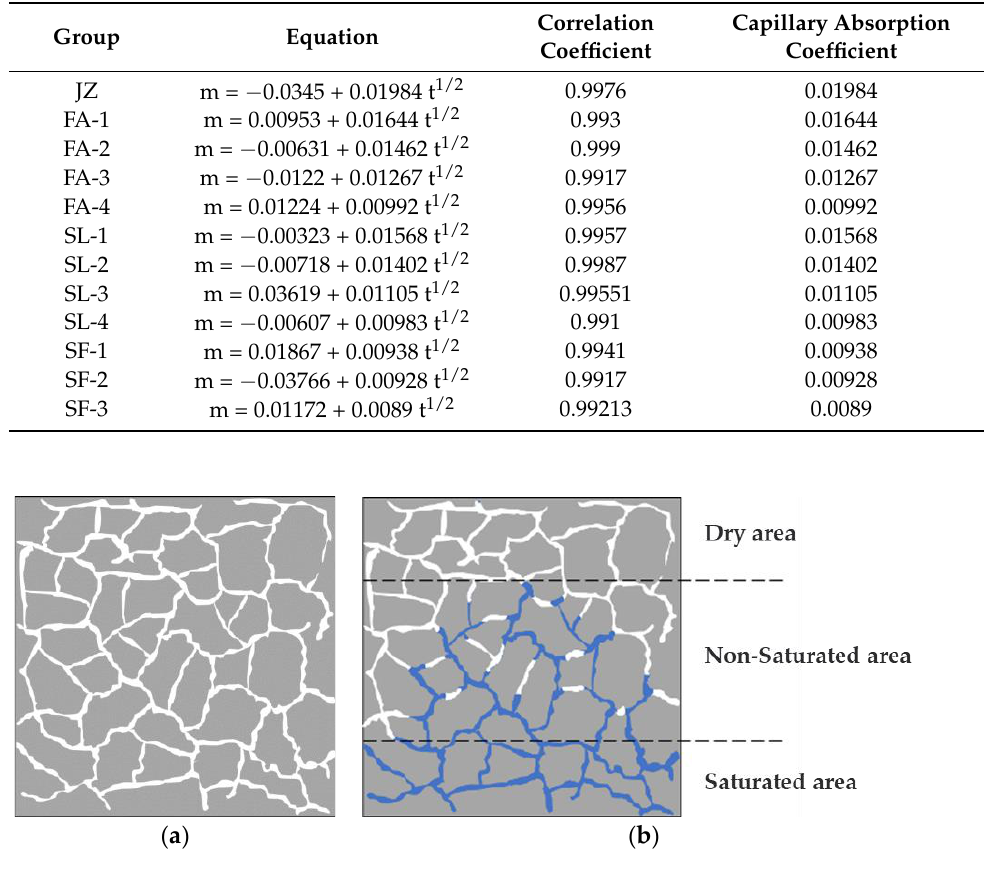
Figure 9. Diagram of a cement mortar opening pore: ( a ) Opening pore structure under dry conditions. ( b ) Opening pore structure under capillary water absorption.